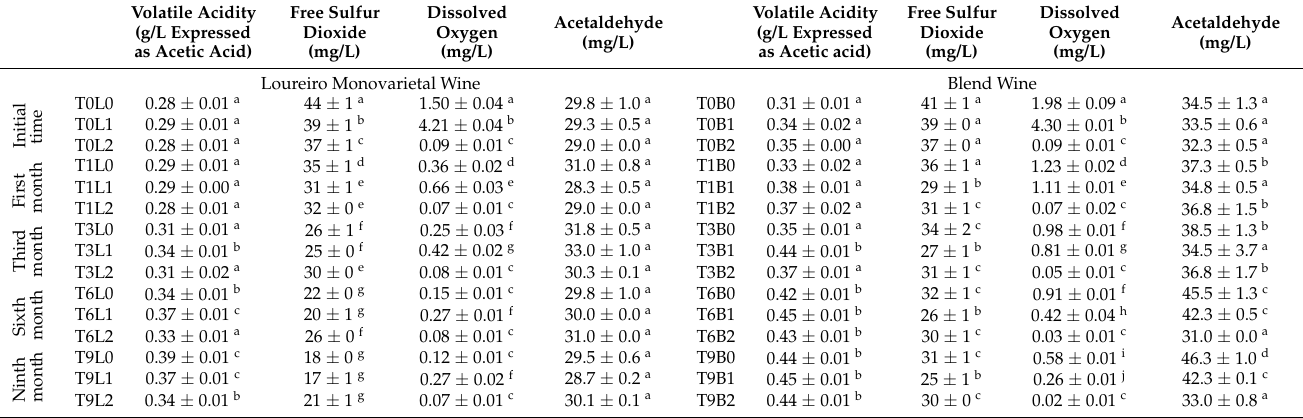
Time: T0 (initial time), T1 (first month), T3 (third month), T6 (sixth month), T9 (ninth month). Wine: L—Loureiro monovarietal wine, B—Blend wine. Stage: 0—before transportation, 1—after transportation, 2—deoxygenation. Means within a column followed by the same letter are not significantly different according to Tukey’s test ( p < 0.05). n = 3 experimental repetitions, 3 analytical